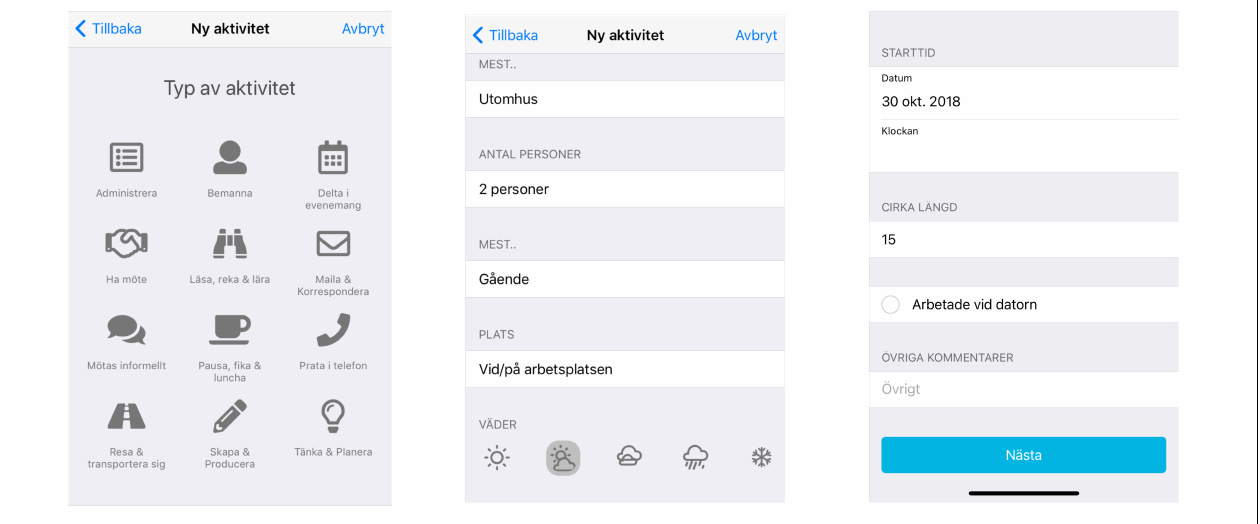
FIGURE 3 | The interface of the mobile